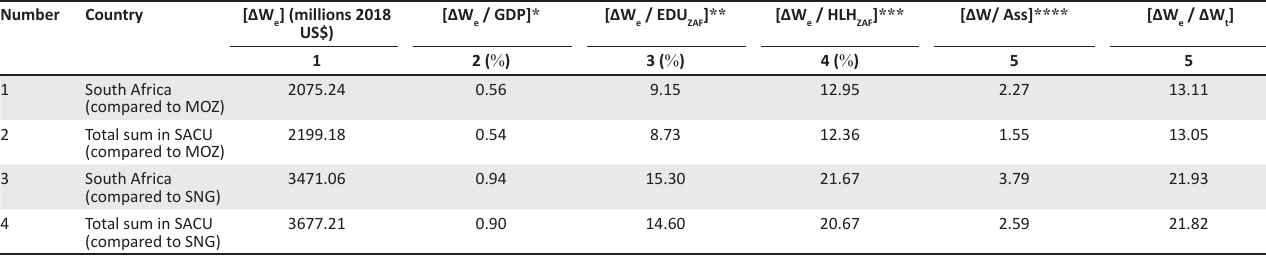
TABLE 7: Economic effects of tariff and total excess compliance cost of the trade. Number Country